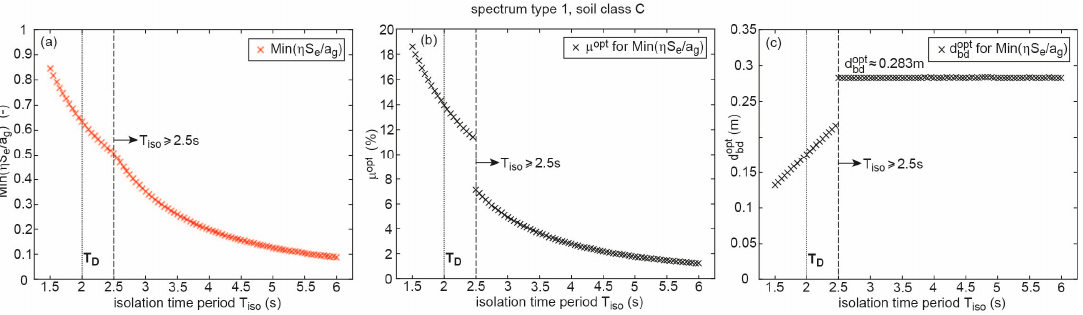
Figure 8. ( a ) Minimum structural acceleration due to optimum selections of ( b ) friction coefficient and ( c ) displacement capacity for spectrum type 1 with soil class C.